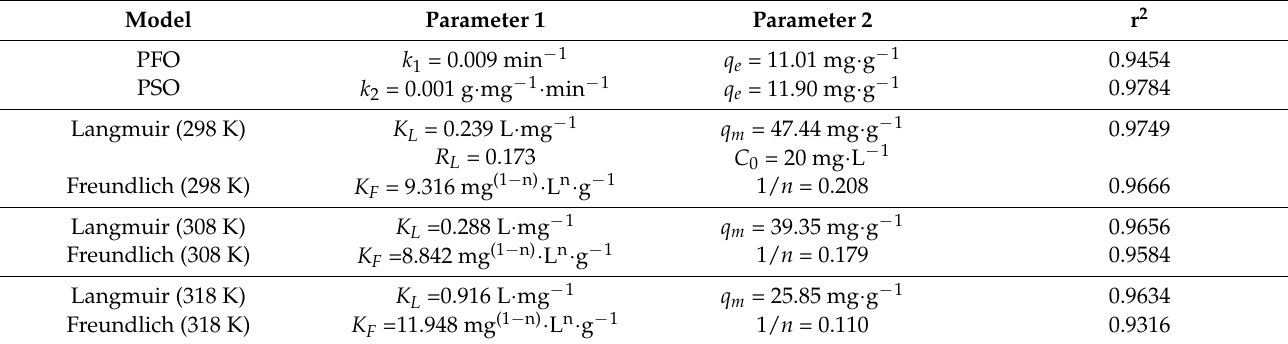
Table 2. Parameters of the Kinetic model and Langmuir and Freundlich isotherm model parameters values for the adsorption of